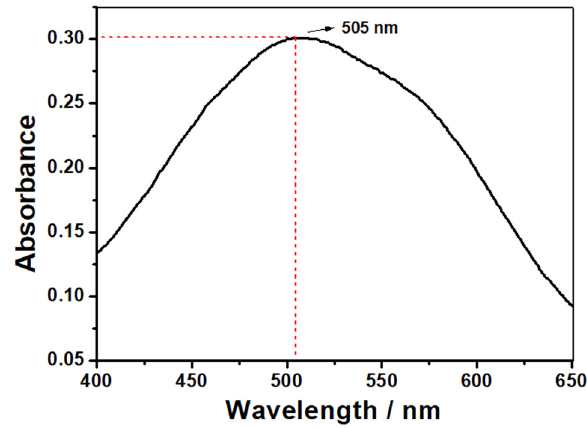
Figure 5: Visible spectrum of ferrate solution.